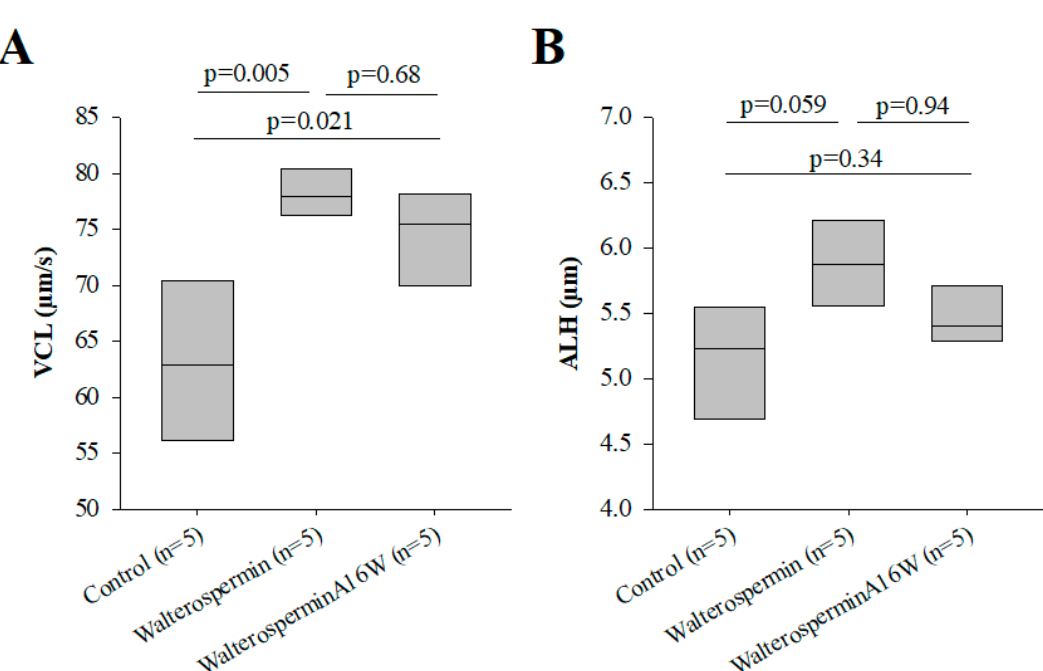
Figure 11. Mutation leading to the loss of protease activity (A16W) does modify the activity of the peptide. ( A ) Increase by 0.2 µM of VCL motility parameters in human sperm of frozen origin. ( B ) As in (A) but for ALH parameter.